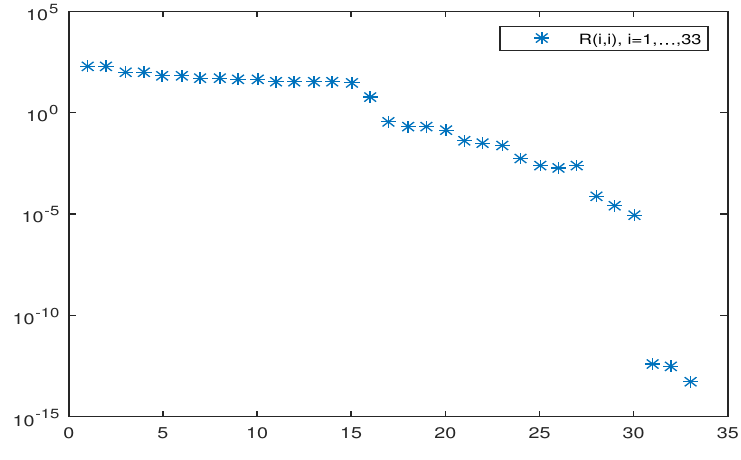
Figure 3. Diagonal entries of R